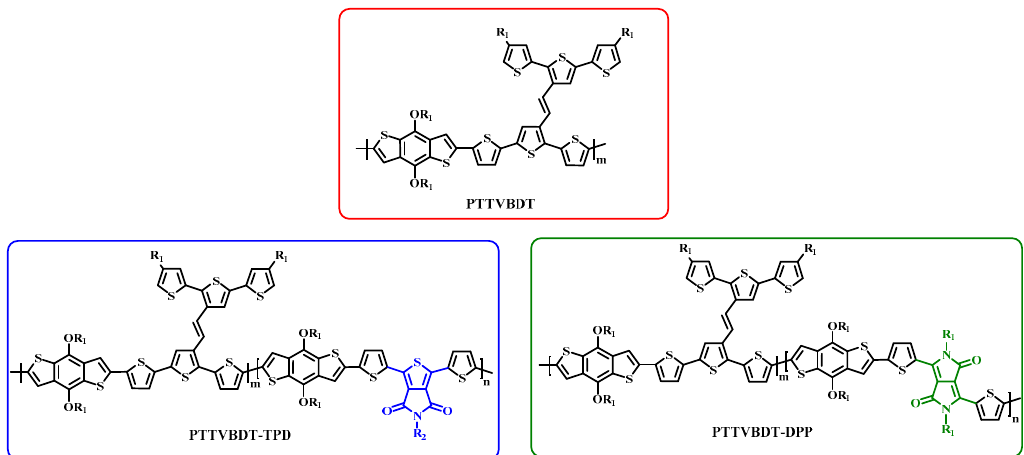
Figure 2. Chemical Structures of PTTVBDT, PTTVBDT-TPD, and PTTVBDT-DPP (R 1 = 2-ethylhexyl; R 2 = n -octyl).